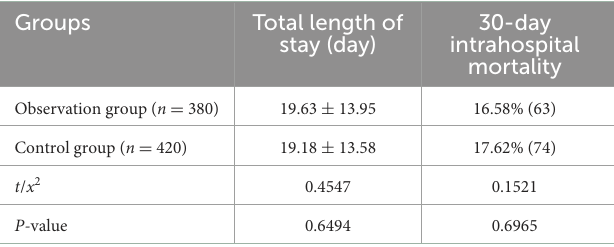
TABLE 6 Length of stay and 30-day intrahospital mortality in the observation and control groups.